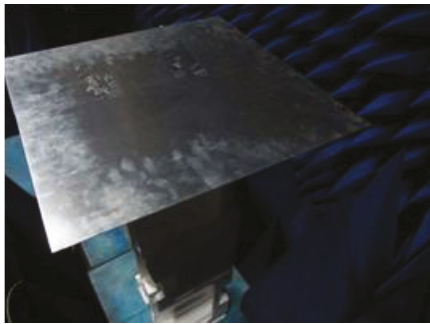
Figure 14: The calibrator for testing the cuboid candles by means of the MIMO array.